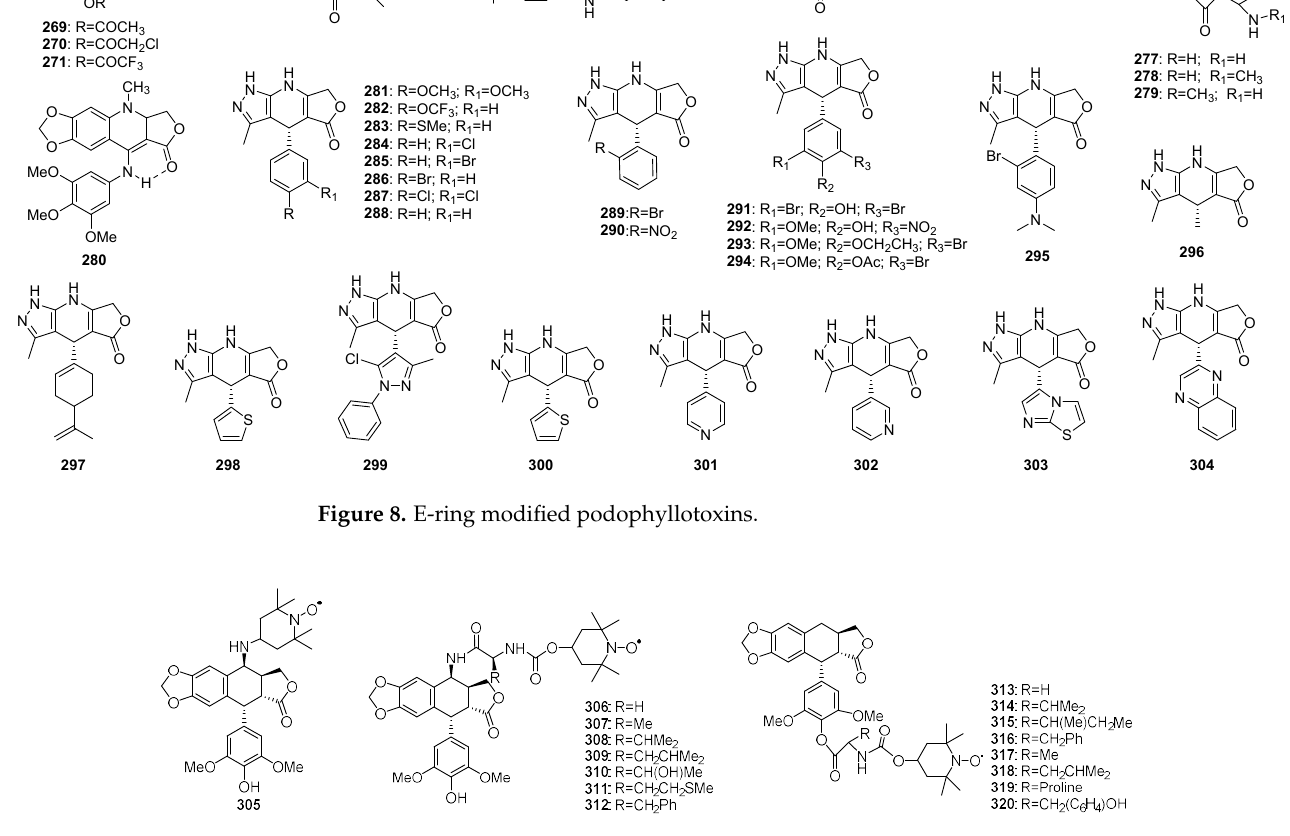
Figure 9. Spin labeled podophyllotoxins.